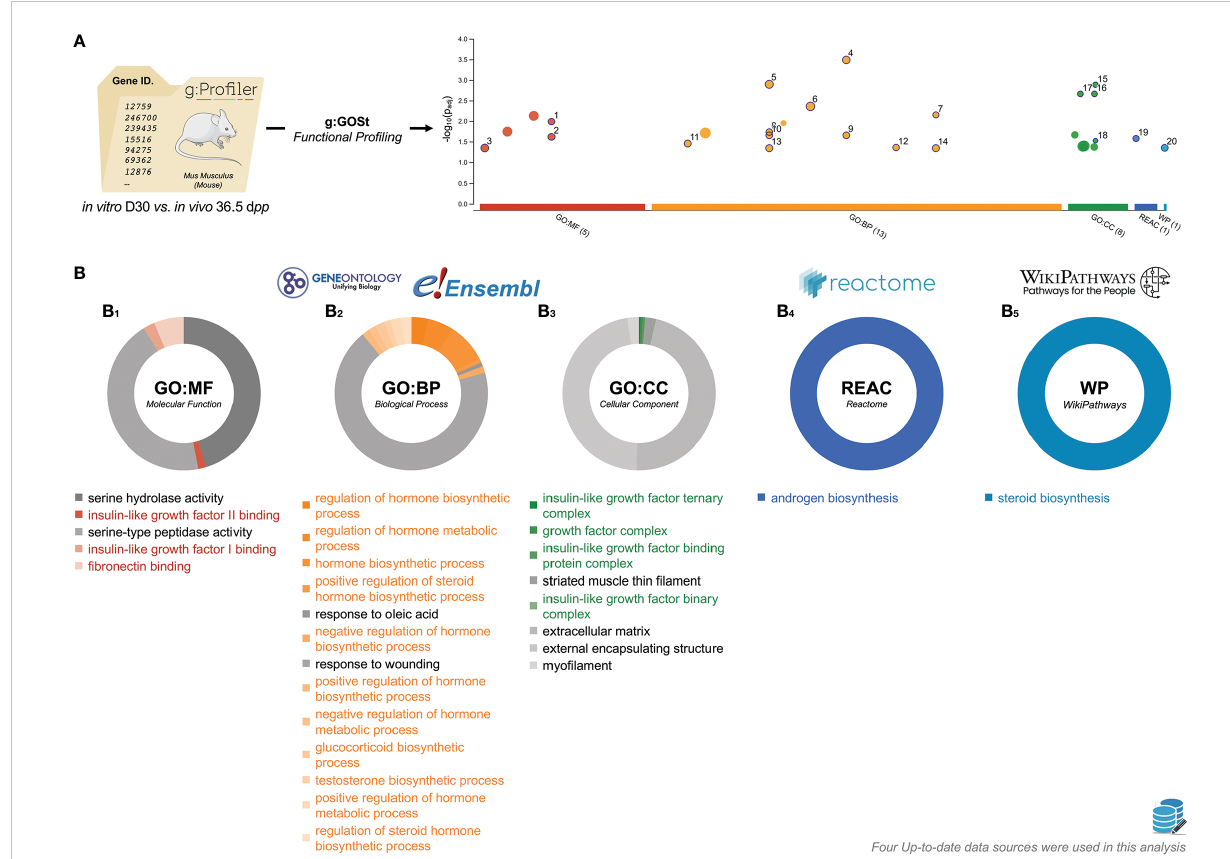
FIGURE 8 Characterization of in vitro D30 vs . in vivo 36.5 d pp gene lists. (A) Manhattan plot illustrating the functional enrichment analysis on in vitro D30 (n=4) vs . in vivo 36.5 d pp (n=3) input gene list. The x-axis represents functional terms that are grouped and colour-coded by data sources. The circle sizes are in accordance with the corresponding term size ( i . e ., larger terms have larger circles). The GO Terms locations on the x-axis is fi xed and GO Terms from the same GO subtree are located closer to each other. The GO Terms lists were presented as -log 10 (p adj ) enrichment score calculated using the formula log 10 (FDR). (B) Pie chart representation of D30 vs . 36.5 d pp GO Terms (B 1 , molecular function; B 2 , biological process; B 3 , cellular component ) , reactome (B 4 ) , and WikiPathways (B 5 ) data sources. GO Terms with the highest p adj are located at noon. The surface taken by GO Terms is relative to the proportion of the number of times they were related within DEGs studied. The data can be consulted at https://biit.cs.ut.ee/ gplink/l/humNT-dmTT. dpp, days postpartum ; FDR, false discovery rate; GO, gene